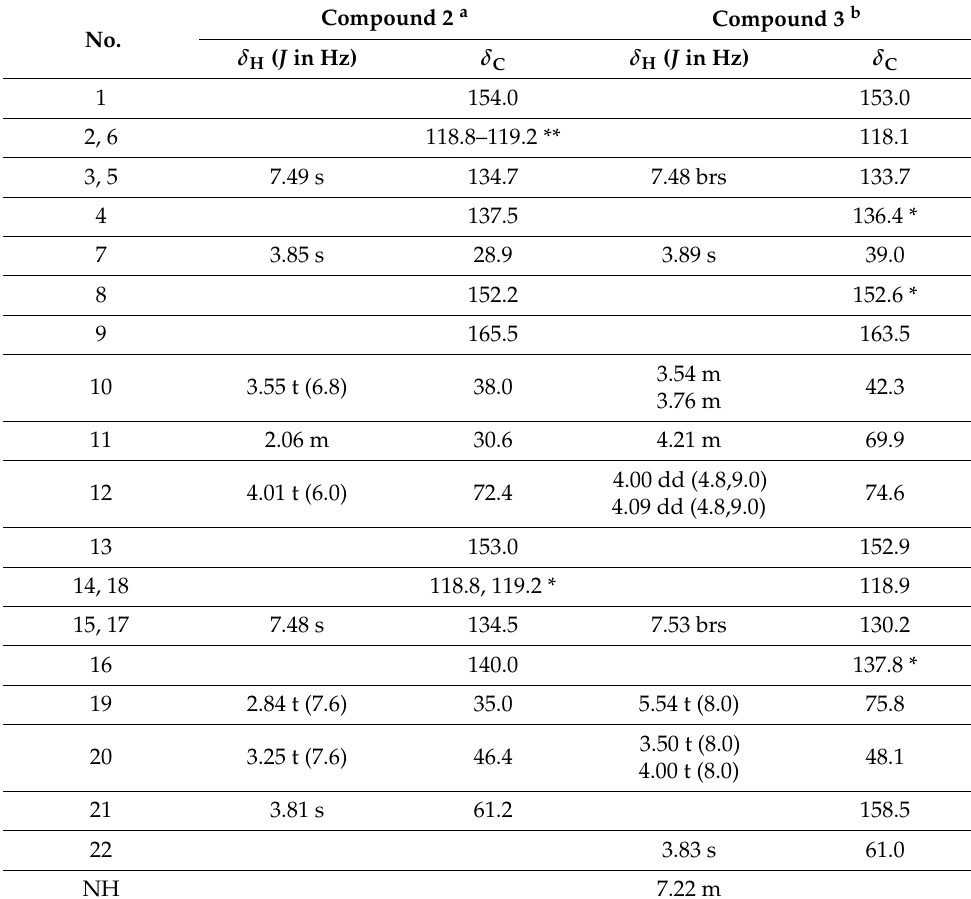
Table 2. 1 H NMR Data ( δ in ppm, J in Hz) of compounds 2 (400 MHz) and 3 (600